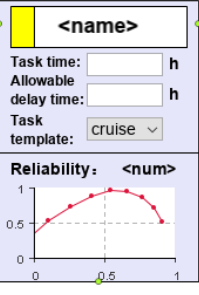
Figure 2. The icon for unit task agent.